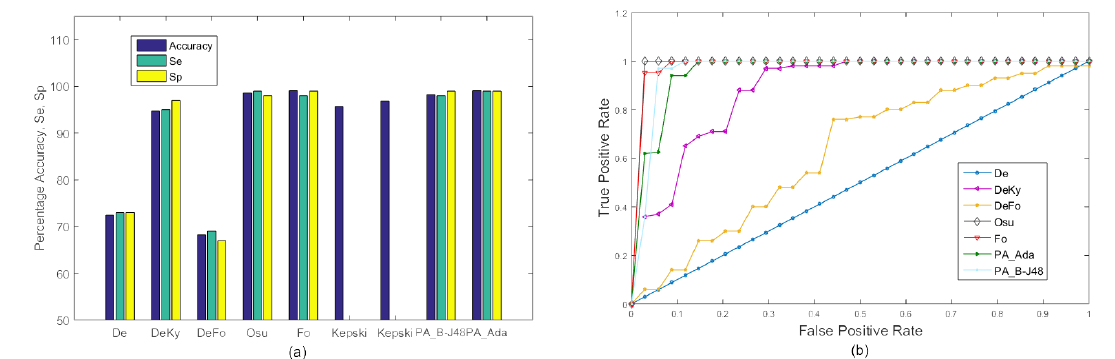
Figure 7. Experiments on the URFD dataset: comparison of accuracy, Se and Sp between the existing approaches under consideration and the proposed approach on the frontal and overhead data sequence from the URFD dataset. ( a ) Graph; ( b ) ROC curve.